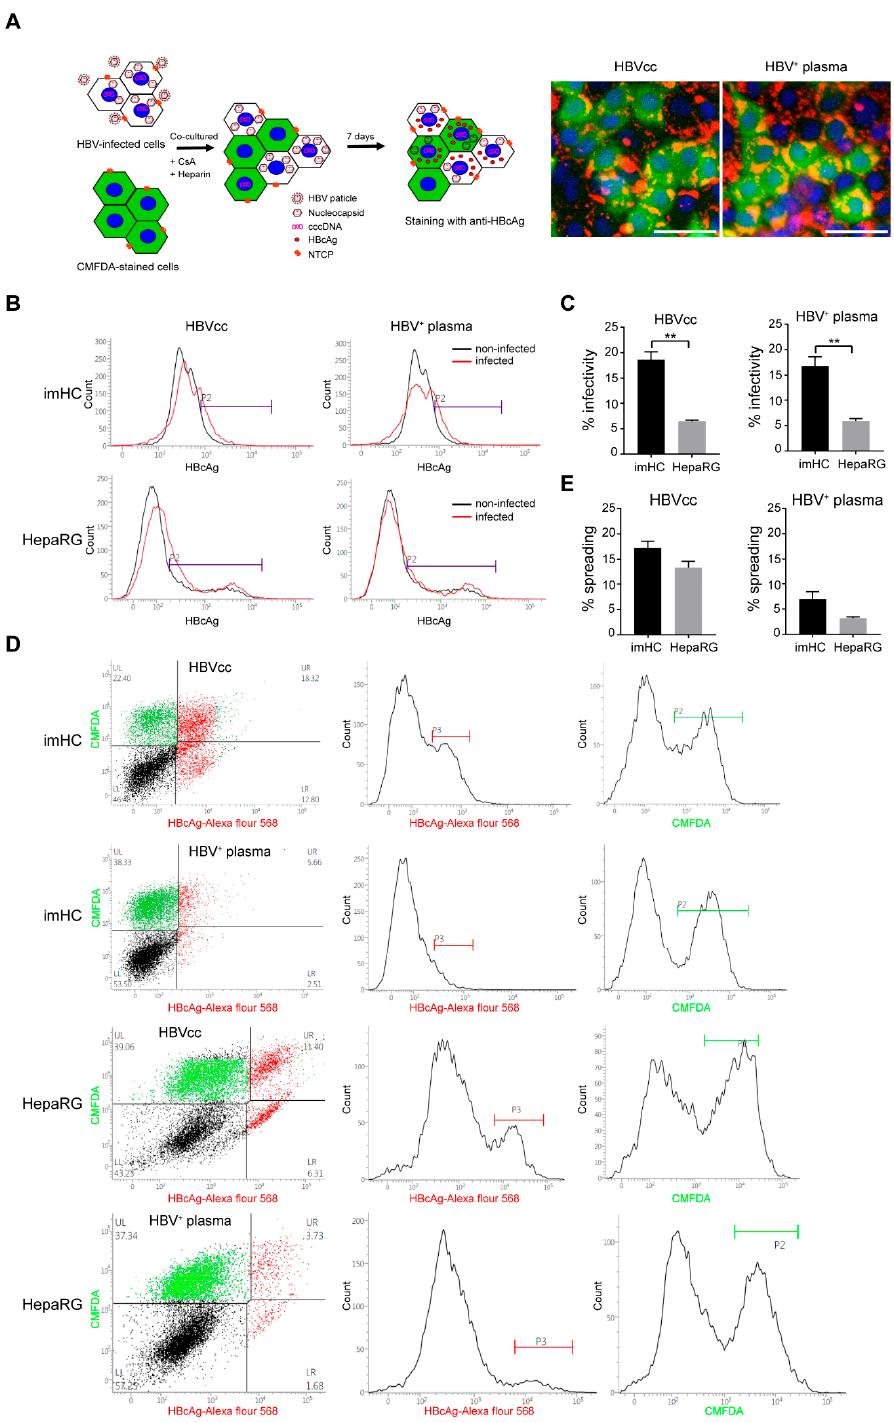
Figure 7. HBV spreading from infected hepatocytes to non-infected cells. Infected hepatocytes were co-cultured with non-infected cells pre-strained with CMFDA. The viral spreading was identified by double positive strained with CMFDA and HBsAg, using a flow cytometer. The diagram of the imHC co-culture model and HBV spreading were illustrated ( A ) with 50 µ m scale bars. Population of infected hepatocyte before the co-culture was demonstrated in imHC and HepaRG ( B ) and the percent of infection was analyzed ( C ). Flow cytometry data revealed HBV spreading from infected hepatocytes as CMFDA and HBcAg-Alexa flour 568 double positive cells ( D ). Quantitative analysis of HBV spreading was reported as a percentage from triplicated data ( E ). Data are presented as mean ± SD. *, **, *** and **** represented statistical di ff erent data with a p -value < 0.05, < 0.01, < 0.001 and < 0.0001,